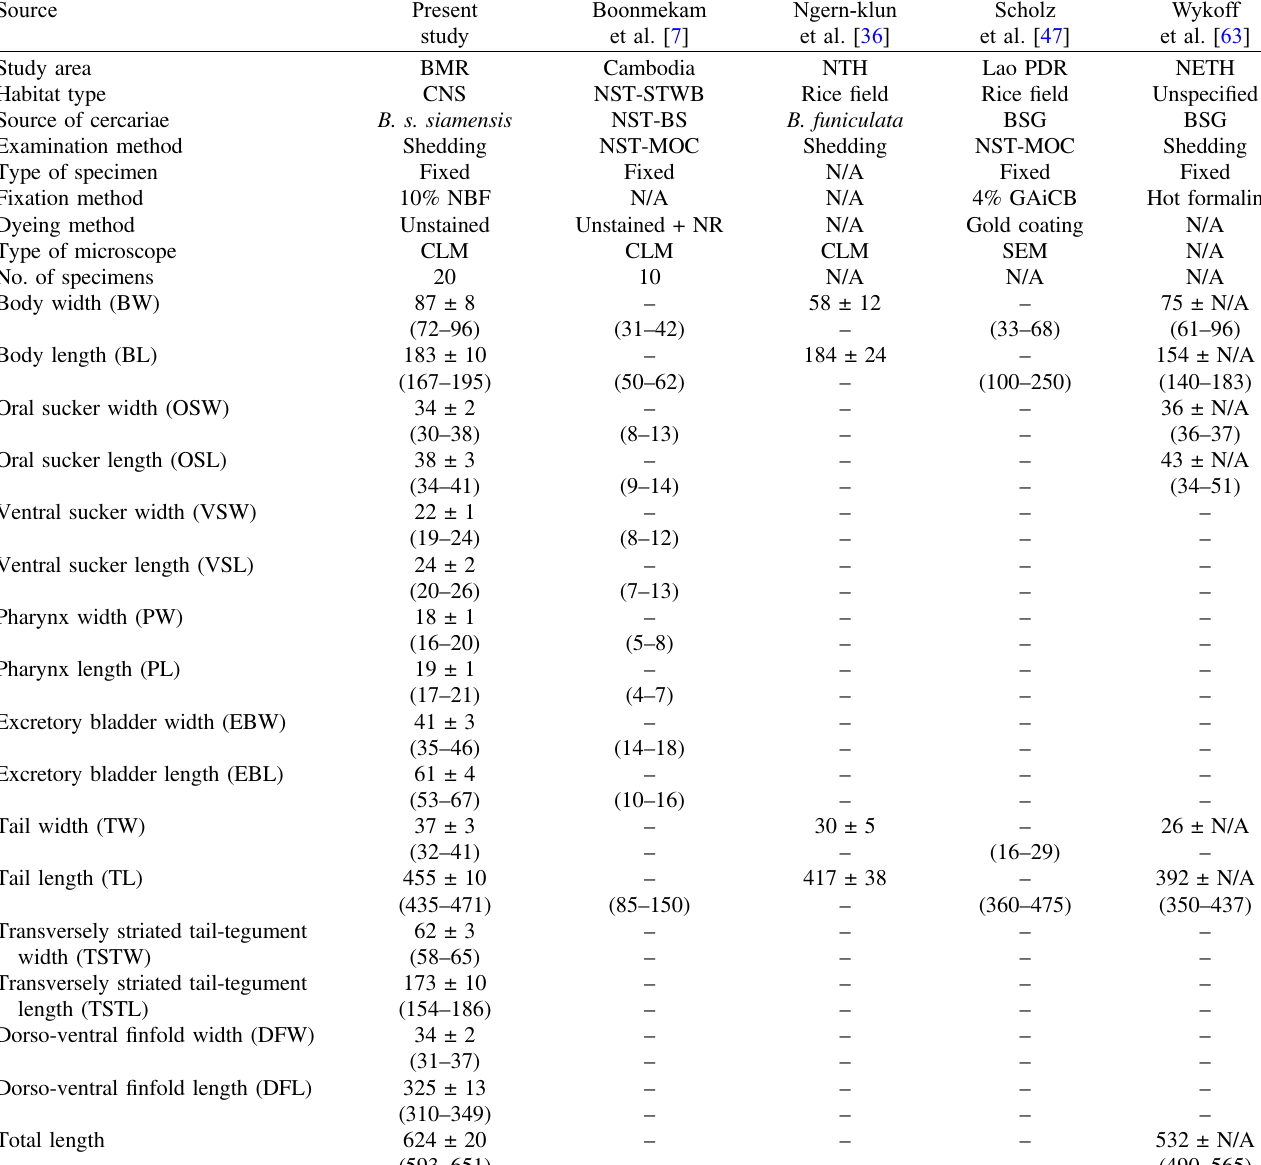
Table 4. Comparison of measured metrical data (in l m) of Opisthorchis viverrini s.l. cercariae from different snail host taxa in different habitats at different areas between the present study and previous